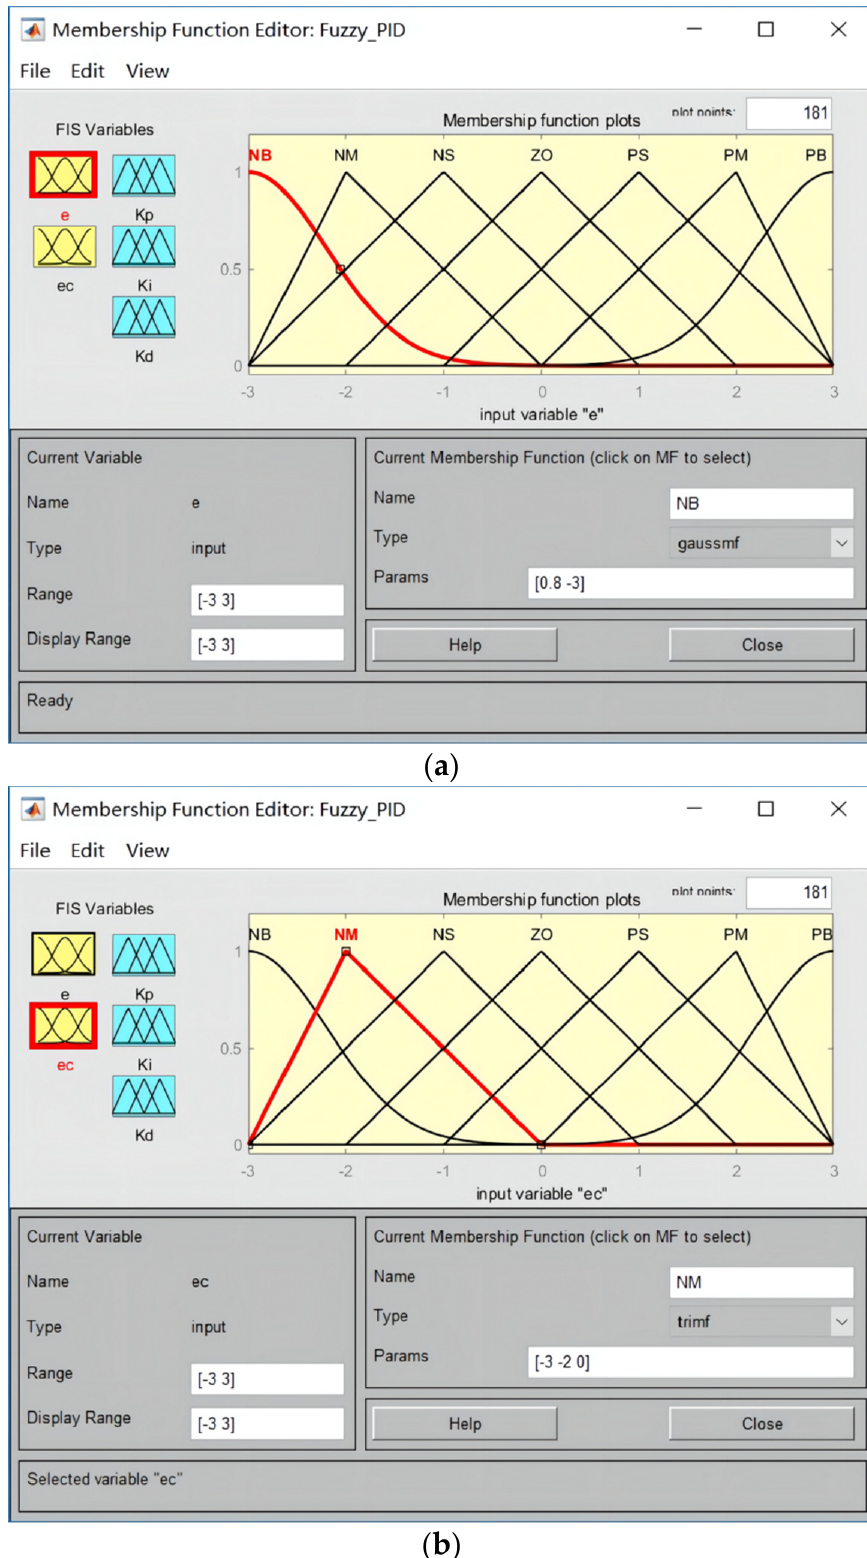
Figure 5. ( a ) Affiliation function curve for input variable e . ( b ) Affiliation function curve for input variable ec .